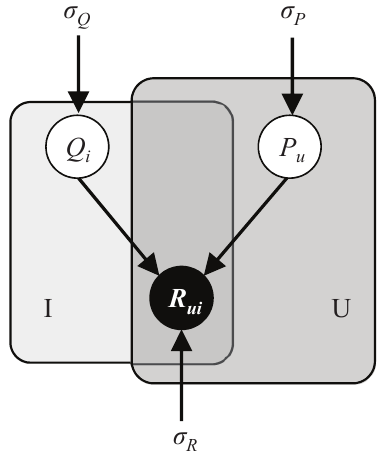
Figure 1. Graphical representation of PMF